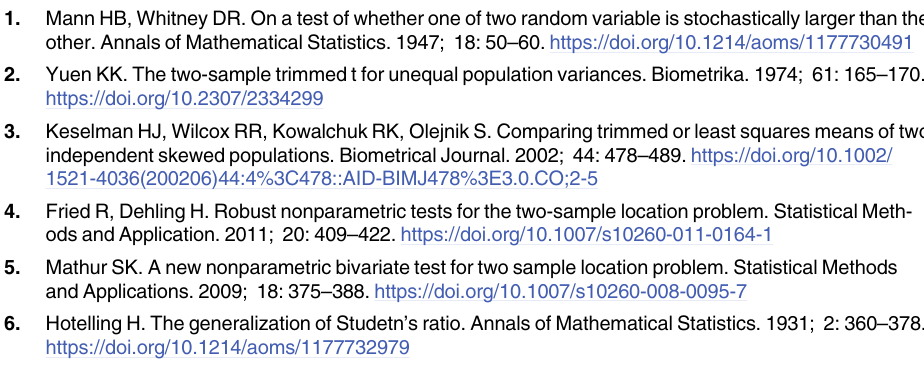
S6 Table. Type I errors ( δ = 0) and power ( δ 6¼ 0) given by the investigated test statistics based on bootstrap approach in detecting location shift between two samples generated from the four pairs of F ( x ) and G ( x ) with the non-independent variance-covariance matrix and sample sizes n = m = 50. S7 Table. Differences between sample means, medians and two Hodges-Lehmann location estimators of intervention and control groups in baseline and 6-month